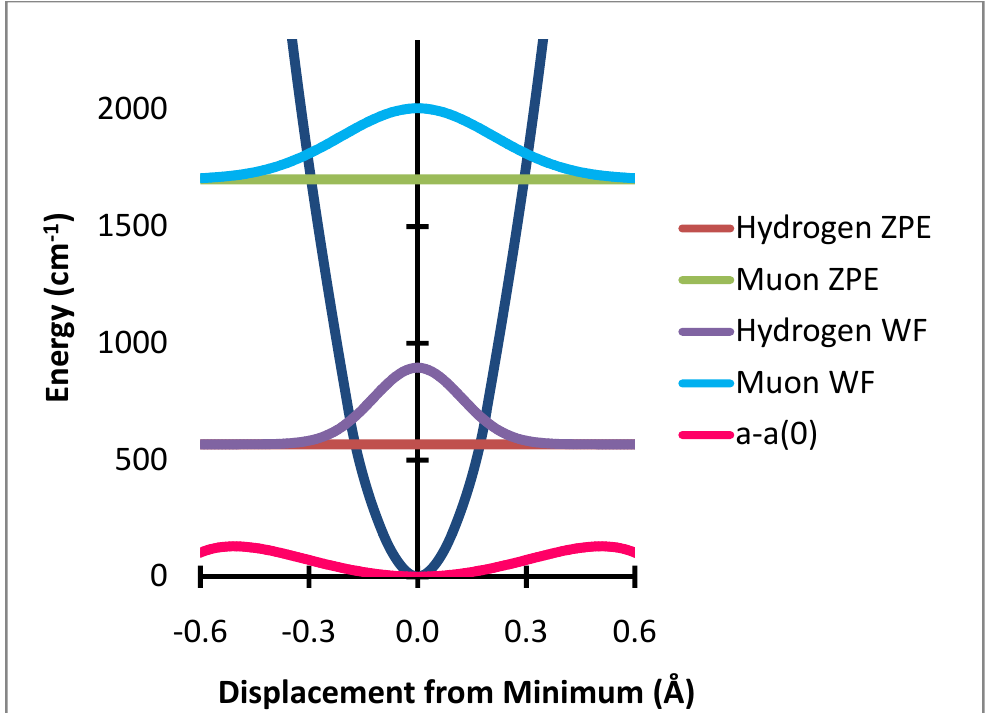
Figure 2. Out of plane bending potential with zero point energy levels and probability distributions for H and Mu and variation of a-a(0) Gauss × 10 4 .